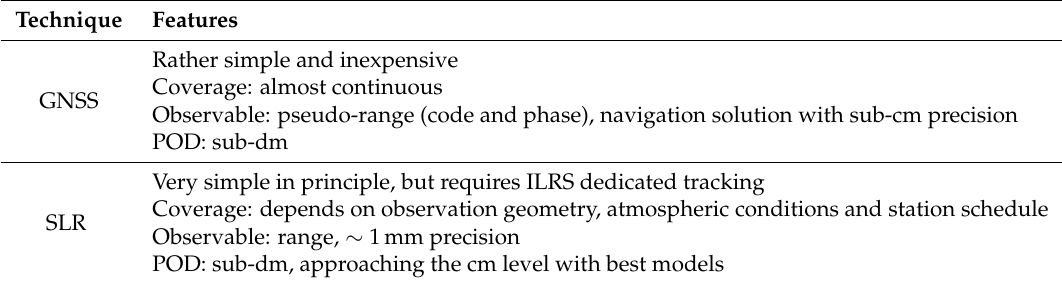
Table 4. Main features of the proposed tracking